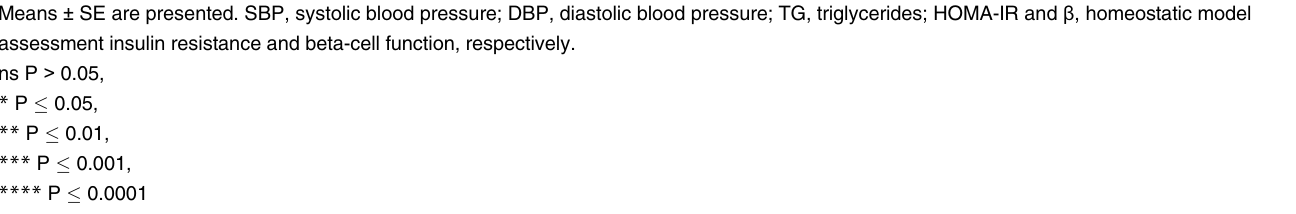
Means ± SE are presented. SBP, systolic blood pressure; DBP, diastolic blood pressure; TG, triglycerides; HOMA-IR and β , homeostatic model assessment insulin resistance and beta-cell function,